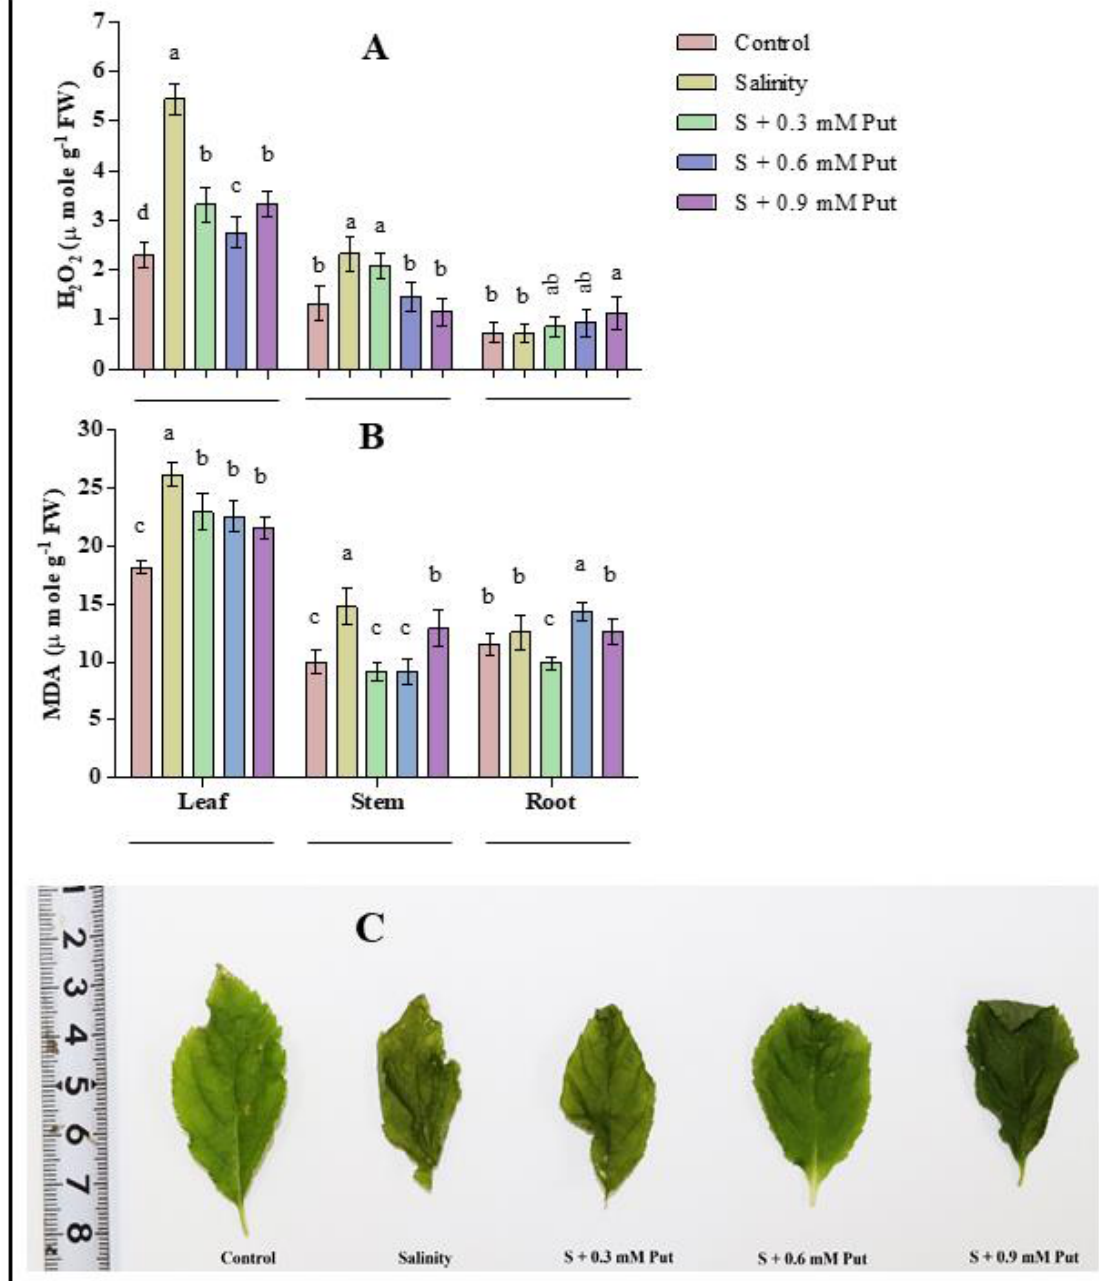
Figure 3. Effect of foliar application of putrescine on hydrogen peroxide ( A ) H 2 O 2 ; malondialdehyde ( B ), MDA accumulation and leaf necrosis of ginseng seedlings grown under salinity stress condition ( C ). Different letters indicate significant differences ( P ≤ 0.05) among the treatments within each parameter. Each value represents the mean ± SD ( n =